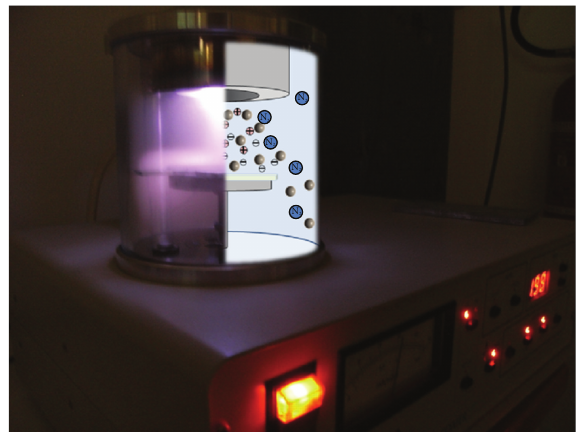
Figure 3: Sputtering system for metal deposition.